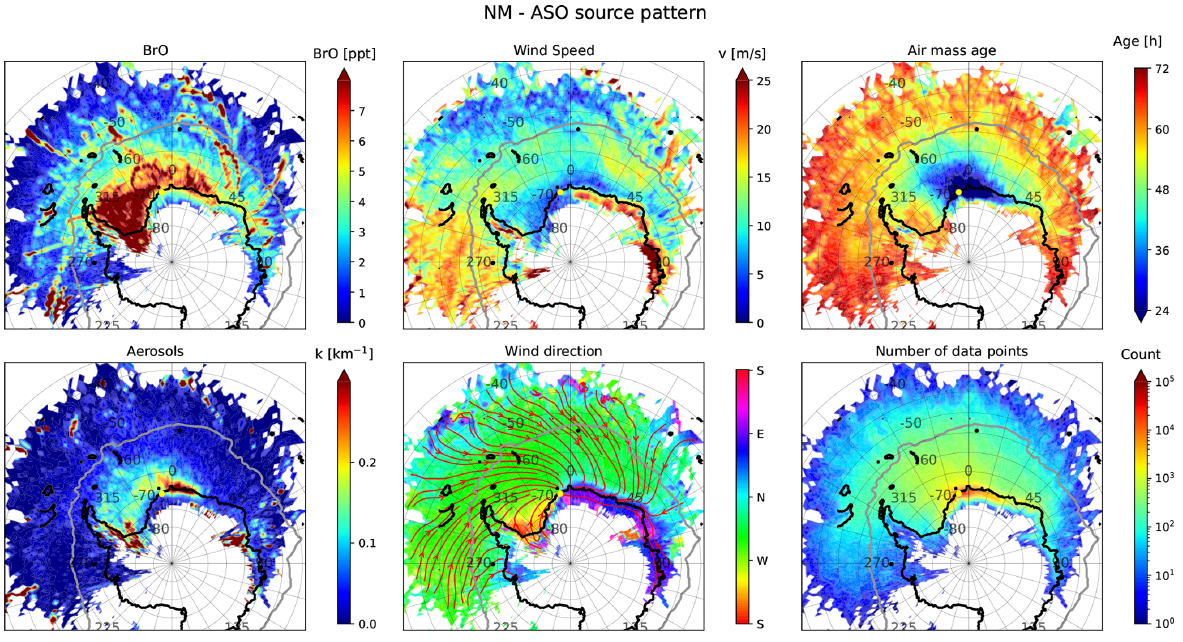
Figure 12. Source–receptor maps of BrO at NM during ASO, together with source–receptor maps of mean aerosol extinction, wind speed, wind direction, and air mass age, as well total number of air parcels, within each 1 ◦ × 1 ◦ grid cell. The thick grey line indicates the mean location of the sea ice edge during ASO. The wind direction plot also contains average stream lines of the airflow (red lines with arrows). The yellow dot indicates the location of the measurement site.